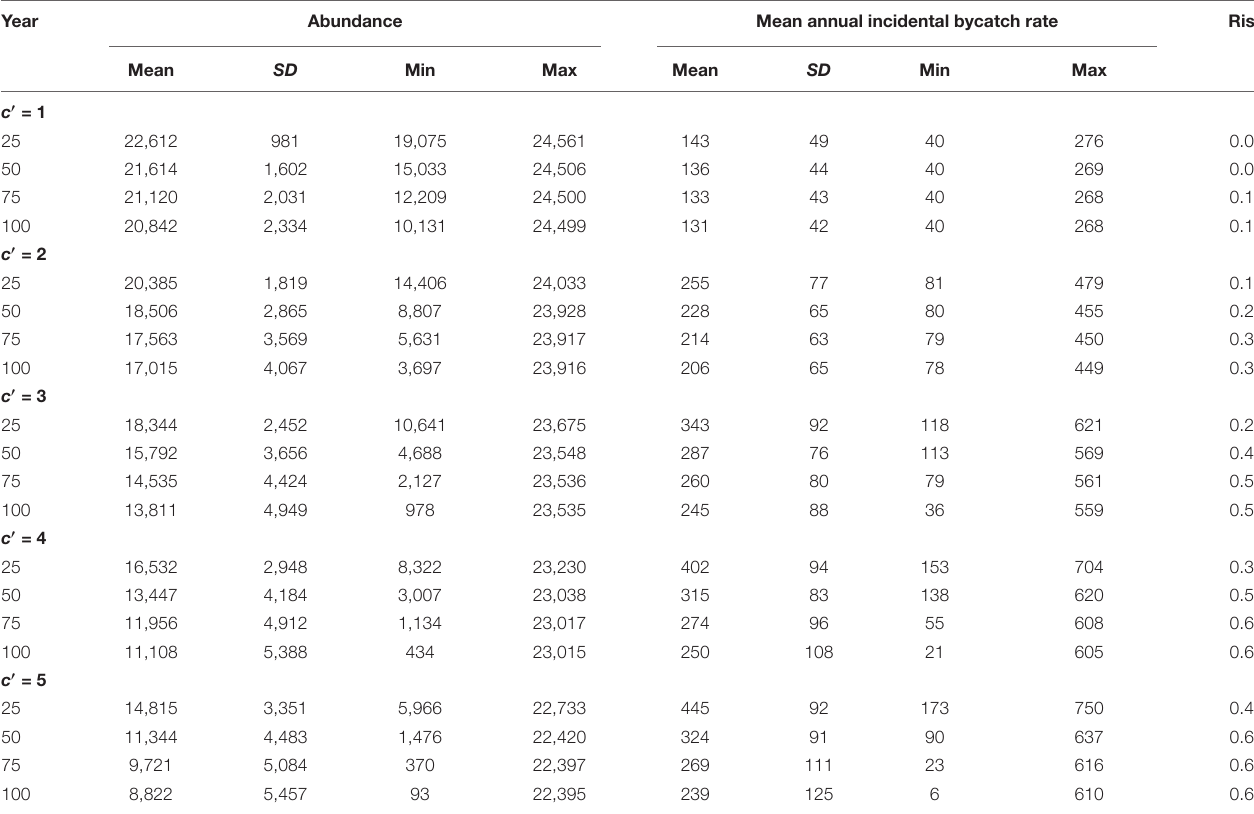
TABLE 2 | Results of exploratory modeling scenarios for the loggerhead population-incidental bycatch system in the Gulf of Ulloa, Mexico (Risk = probability of reaching the critical ecological threshold). Year Abundance Mean annual incidental bycatch rate